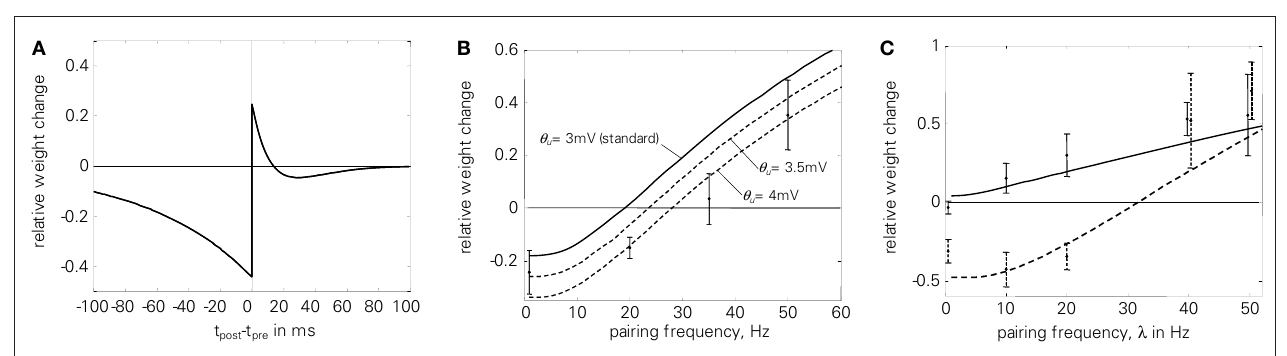
experiment (8). Error bars denote data for unconditioned synapse by Ngezahayo FigurE 12 | (A, B) ; Quadruplet protocol (4) using LCP with LIAF: (A) same et al. (2000). Froemke 1 STDP parameters with downscaled weight amplitudes parameters as in Figure 8B , but all-to-all interaction (Wang parameter set in were used, and the voltage threshold was shifted according to the experimental Table 4 ), E = 1.9; (B) all-to-all interaction, with attenuation ( α = 0.8), which is att data (see Ngezahayo parameter set in Table 4 ). Normalized error: E = 177. compensated by PSP influence: U = Θ = 2 mV; E = 1.2. (C) Voltage control PSP u